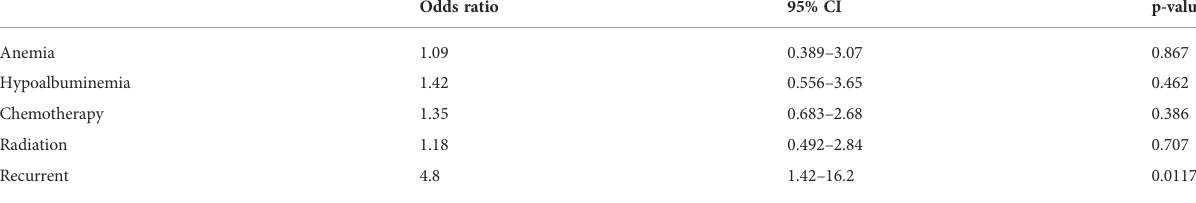
TABLE 5 Logistic regression analysis on zinc de fi ciency following cancer treatment.